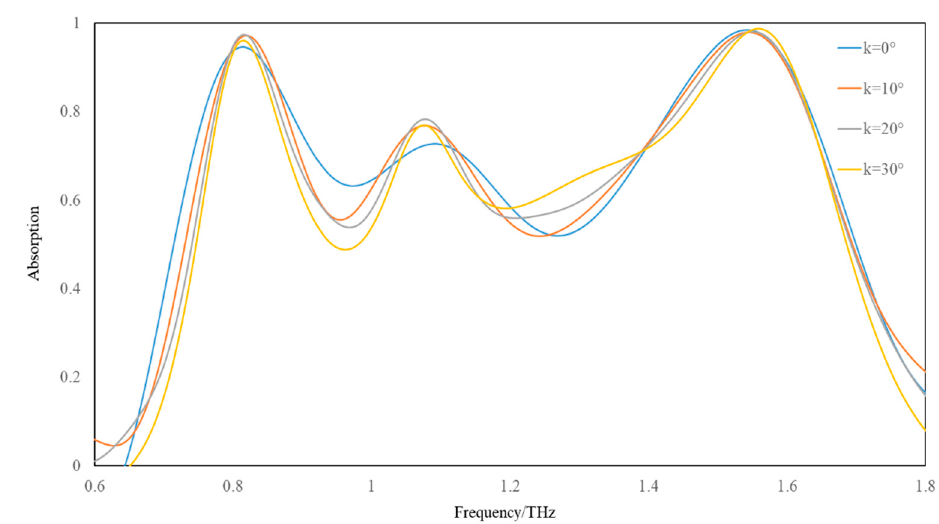
Figure 7. Absorption of the incident angle k of the incident electromagnetic wave propagating to the absorbing structure. The blue line indicates the absorption rate at k = 0 ◦ , the orange line indicates the absorption rate at k = 10 ◦ , the grey line indicates k = 20 ◦ and the yellow line indicates k = 30 ◦ .